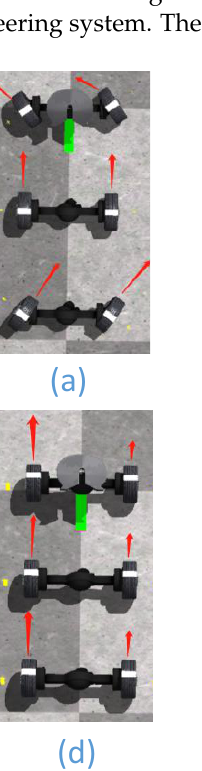
Figure 7. Six steering motion modes of six-wheel distributed unmanned vehicle: ( a ) four-wheel Akerman steering; ( b ) two-wheel Akerman steering; ( c ) crab walking; ( d ) differential steering; ( e ) differential center steering; ( f ) center steering. The direction of the red arrow is the direction of the wheel movement.